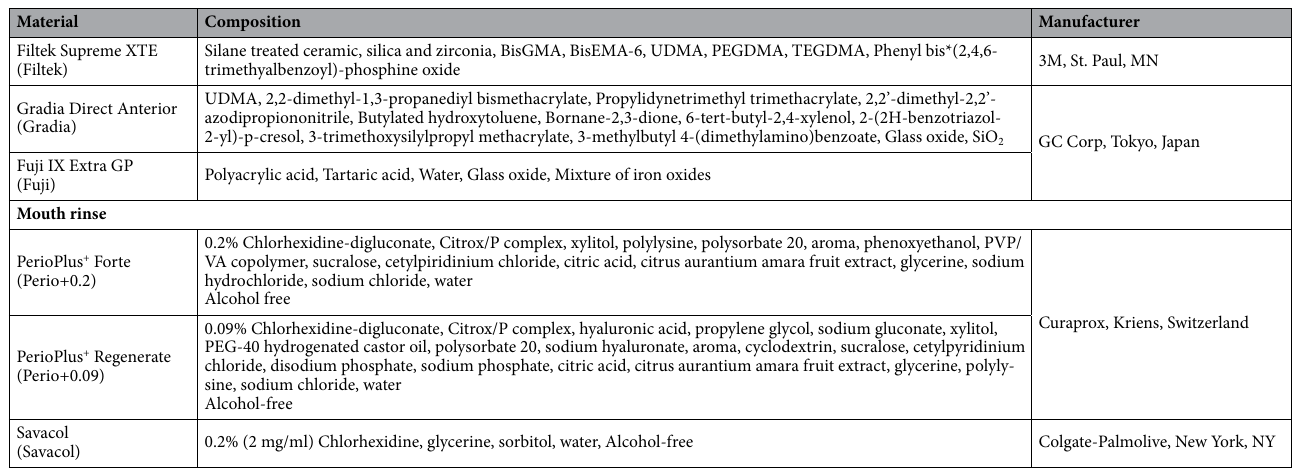
Table 4. Details of tested materials and mouth rinses. BisGMA bisphenol A diglycidyl ether dimethacrylate, BisEMA-6 bisphenol A polyethylene glycol diether dimethacrylate, UDMA diurethane dimethacrylate, PEGDMA polyethylene glycol dimethacrylate, TEGDMA triethylene glycol dimethacrylate, PVP-PA polyvinylpyrrolidone/vinyl